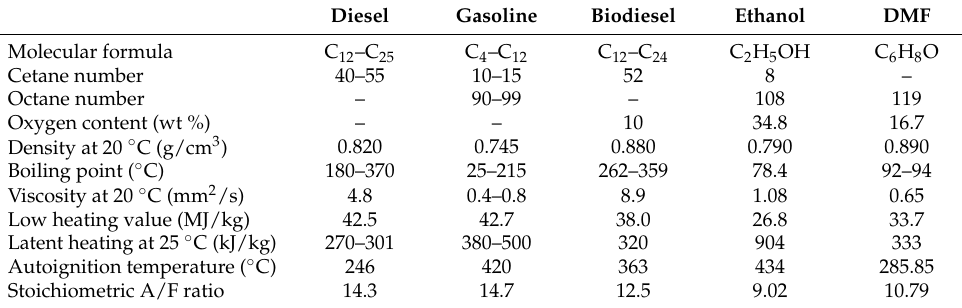
Table 1. Properties of diesel, gasoline, biodiesel, ethanol and DMF [14,15].